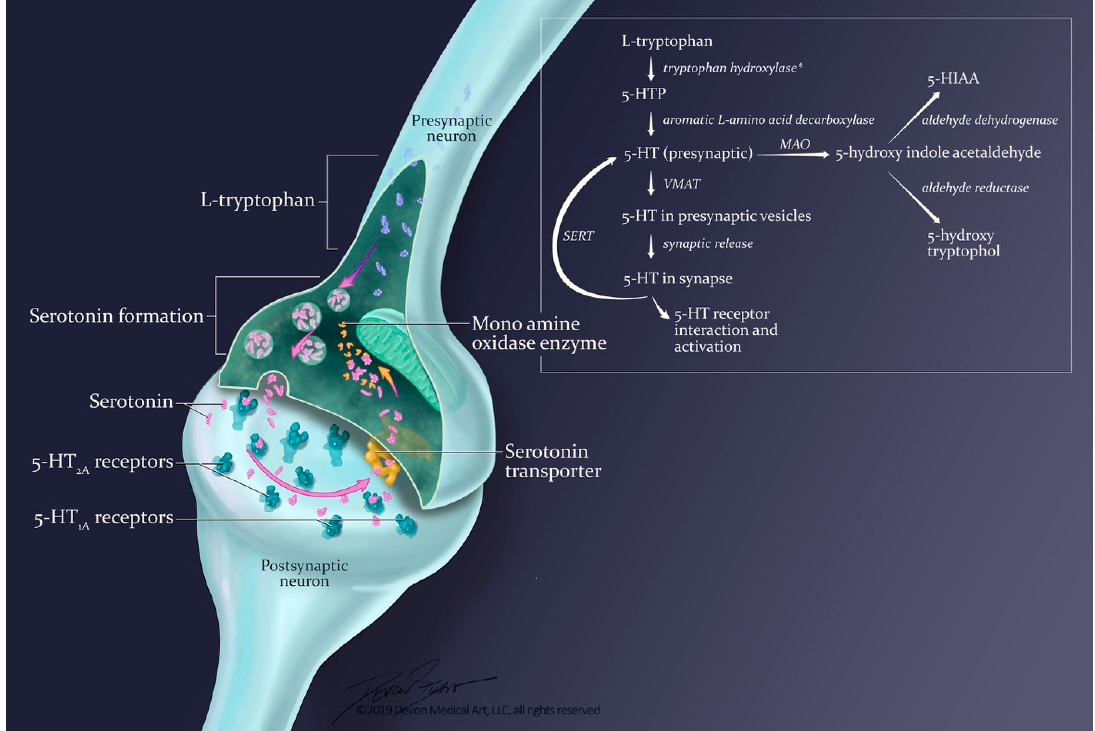
Figure 2. At normal serotonergic neurons, the concentration of serotonin at a synapse is determined by several processes, including synthesis, controlled release from the presynaptic neuron, reuptake, and metabolism. 5-HTP = 5-hydroxytryptophan; 5-HT = 5-hydroxytryptamine (serotonin); VMAT